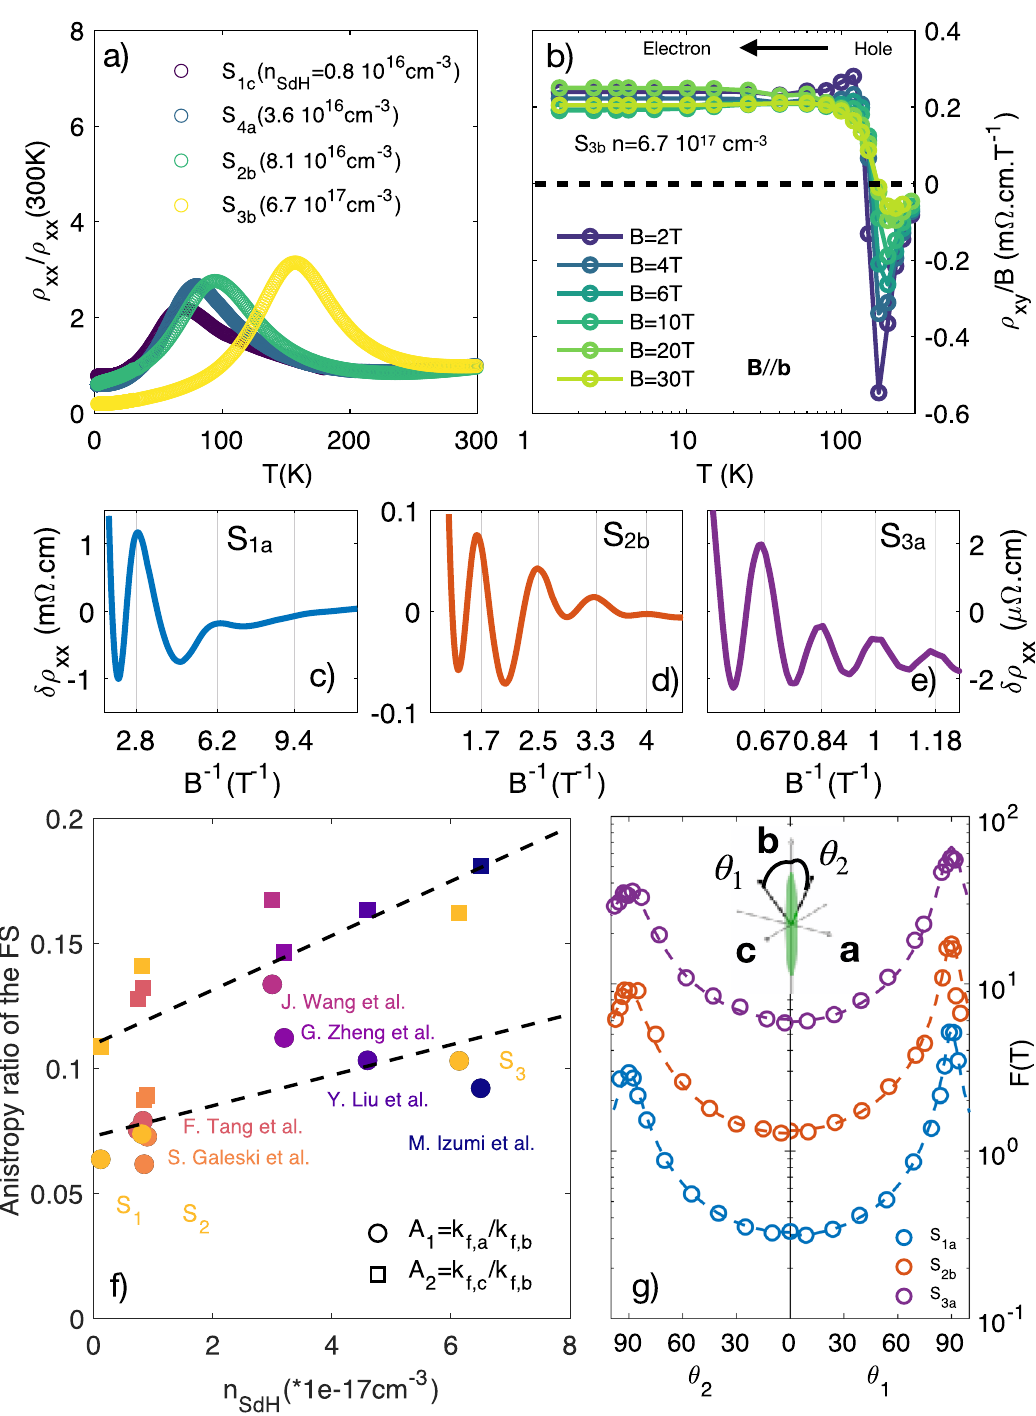
Fig. 1 Doping evolution of the Fermi surface of ZrTe 5 . a Temperature dependence of ρ xx for the four different batches studied, labelled respectively S 1,2,3,4 . Samples from the same batch are labelled by distinct subscript letters. n SdH is the carrier density deduced from quantum ρ xy = 6.7 × 10 17 cm − 3 ). The dashed line indicates the zero value of ρ oscillations (see Supplementary Note 2). b vs B for S 3 b (n S xy . B 3 c – e Shubnikov-de Haas quantum oscillations measured in the three samples S 1 a , S 2 a and S 3 b at T = 2 K for B ∥ b . g Angular dependence of the frequency of quantum oscillations ( F ) in open circles as function of θ 1,2 , the angles between the b-axis and the magnetic fi eld rotating in the ( b , a ) and ( b , c ) planes, respectively. The dotted lines are the frequency, F , for an ellipsoid Fermi surface of anisotropy A i k F ; a (cid:3) 1 Þ cos 2 ð θ ÞÞ (cid:3) 1 2 ). For the two planes of rotations, A ( F ¼ F 0 ð 1 þ ð 1 = A 2 and k F ; a , labelled A 1 and A 2 respectively. Their doping i is given by i k F ; b k F ; c evolution is shown in f ) and agrees well with the literature 18,22,24,33,35,52